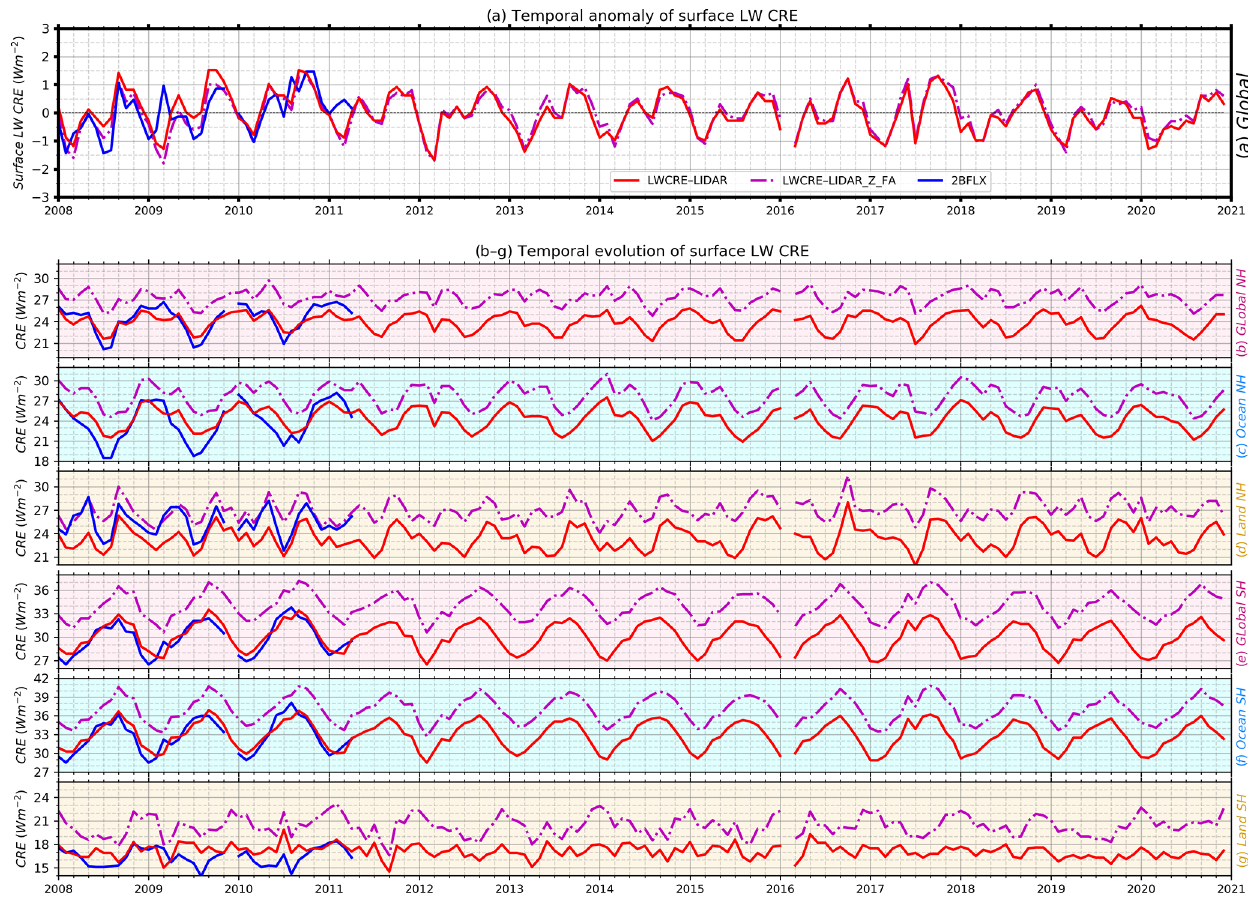
Figure 15. (a) Time series of global surface LW CRE anomalies. (b–f) Time series of surface LW CREs over all NH, ocean NH, land NH, all SH, ocean SH, and land SH. In panel (a) the anomaly is defined as the global average for each month of each product minus its own average over the whole time series. Note that the y -axis scale is different in each